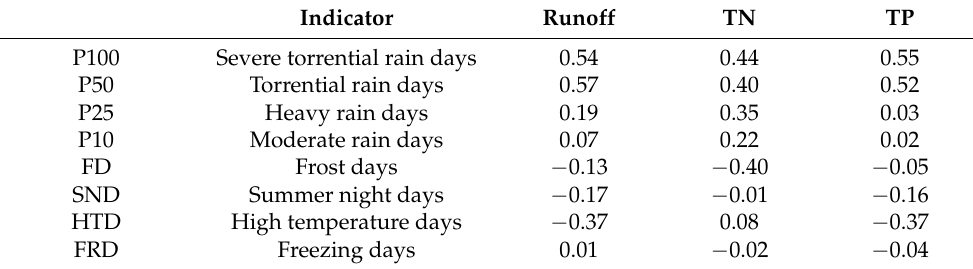
Table 2. Correlation between runoff, TN and TP loads, and extreme climate indicators.